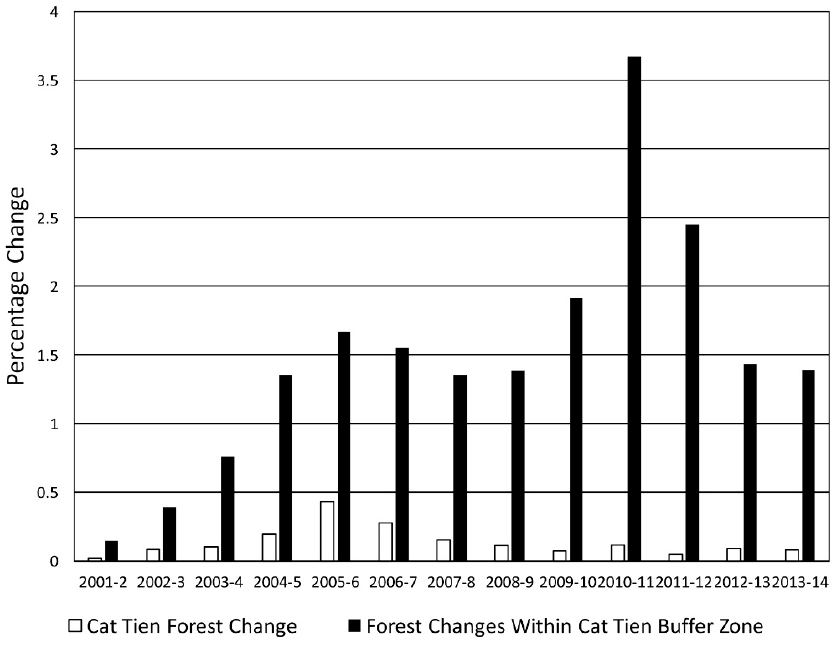
Figure 10. Comparison between forest change due to disturbance in Cat Tien National Park and buffer zone regions. Disturbance changes represent loss of greenness as determined using NDVI difference threshold values between adjacent years.